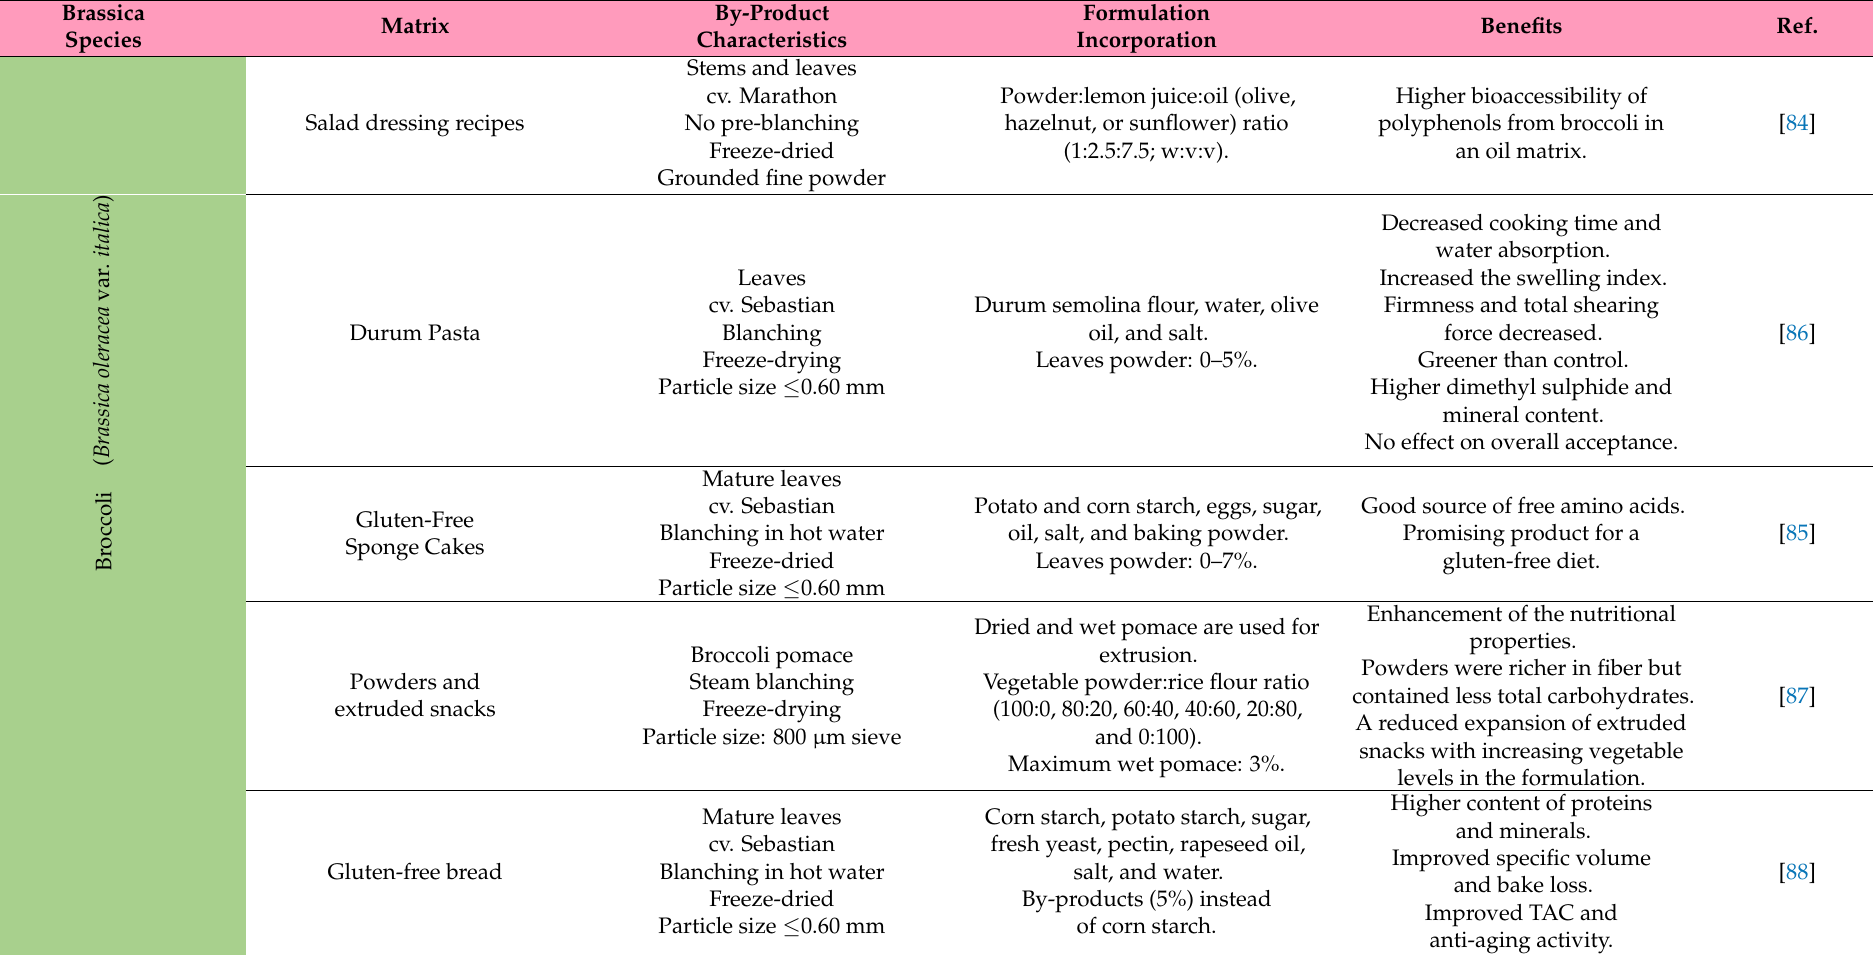
Table 5. Application of Brassica species (by-product characteristics and incorporation method/formulation) and their benefits in different food